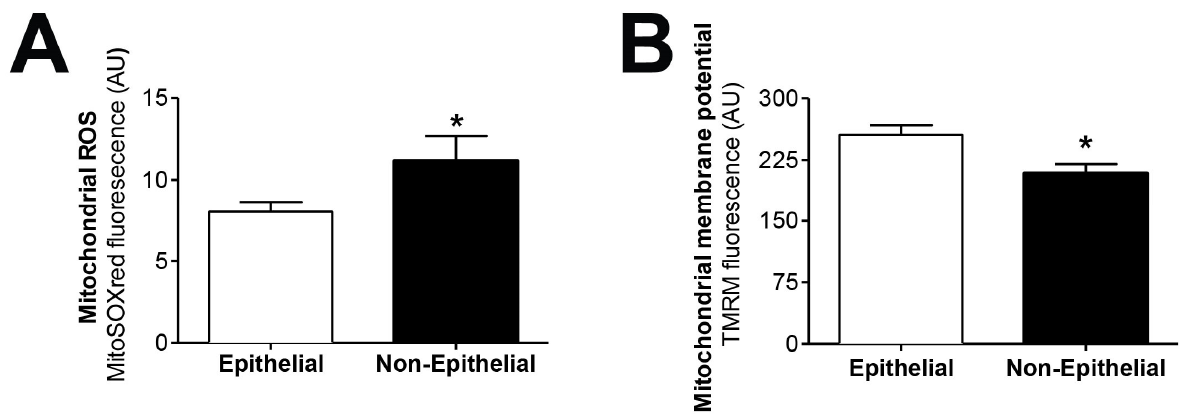
Figure 2. Effluent-derived human mesothelial cells with non-epithelial phenotype exhibit increased mtROS and decreased mitochondrial membrane potential. ( A ) Epithelial and non-epithelial mesothelial cells were stained with MitoSOX Red and analyzed by flow cytometry. Values are the mean ± SEM median fluorescence intensity ( n = 62 epithelial samples and n = 17 non-epithelial samples). * p < 0.05 vs. epithelial cells. ( B ) Epithelial and non-epithelial mesothelial cells were loaded with tetramethylrhodamine methyl ester and analyzed by flow cytometry. Values are the mean ± SEM median fluorescence intensity ( n = 62 epithelial samples and n = 15 non-epithelial samples). * p < 0.05 vs. epithelial cells. PD: peritoneal dialysis.